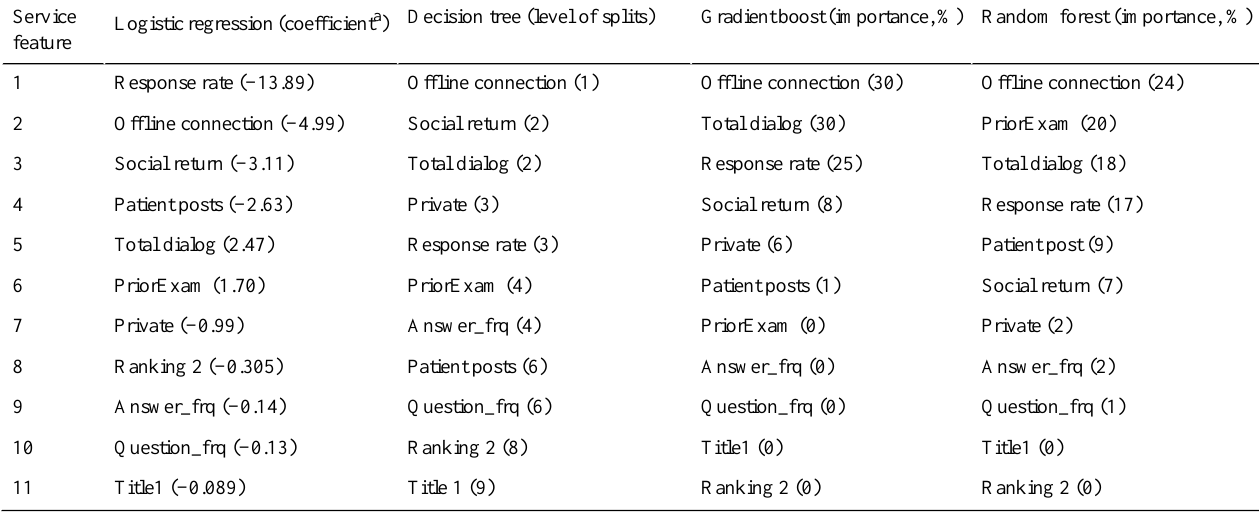
Table 4. Key features listed in descending order of importance.